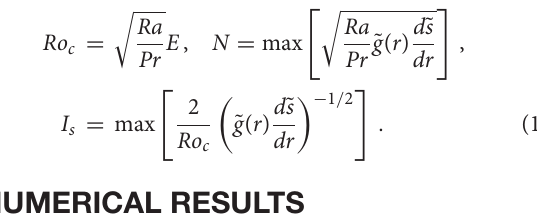
relative to a model without stratification (gray). Along both edges of the SSL region (highlighted in gray), the kinetic energy